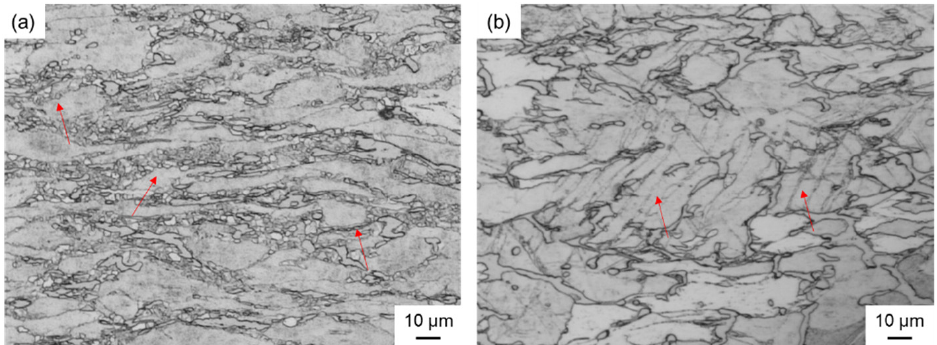
Figure 4. Optical micrographs representing the main DRX mechanism (marked by red arrows) during hot rolling of the twin-roll cast and homogenized WZ73 alloy: ( a ) CDRX, sample#5 and ( b ) TDRX, sample #7.